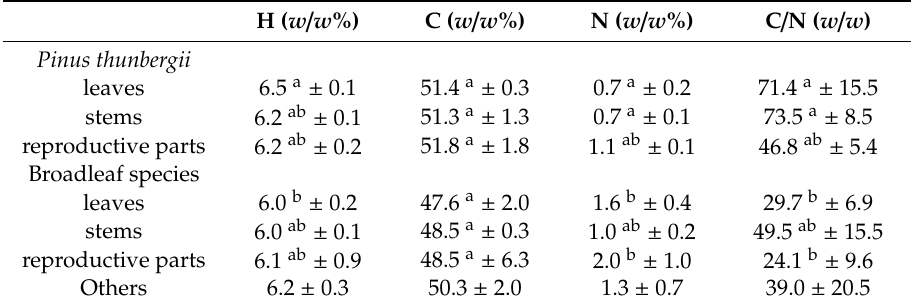
Table 1. Elemental composition in litter collected in litter traps located at four quadrats in the Sanri ‒ Matsubara Forest, northern Kyushu, Japan.